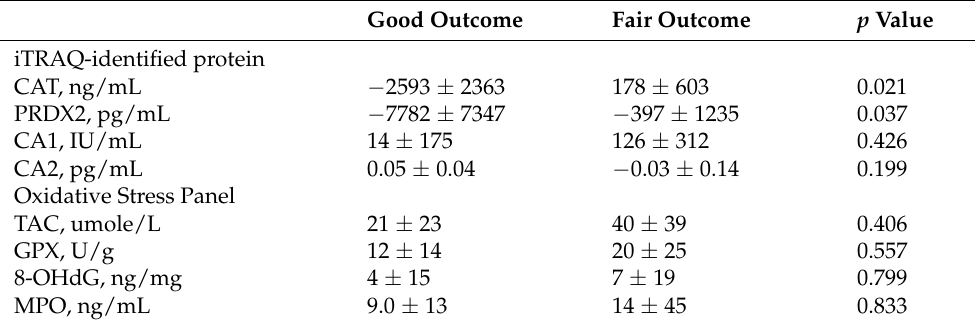
Table 3. Comparison of the expression difference of iTRAQ-identified serum proteins and oxidative stress markers between those patients with good outcomes ( ≥ 40 volume reduction in MR volume- try) and fair outcomes (<40% volume reduction in MR volumetry) following lymphaticovenous